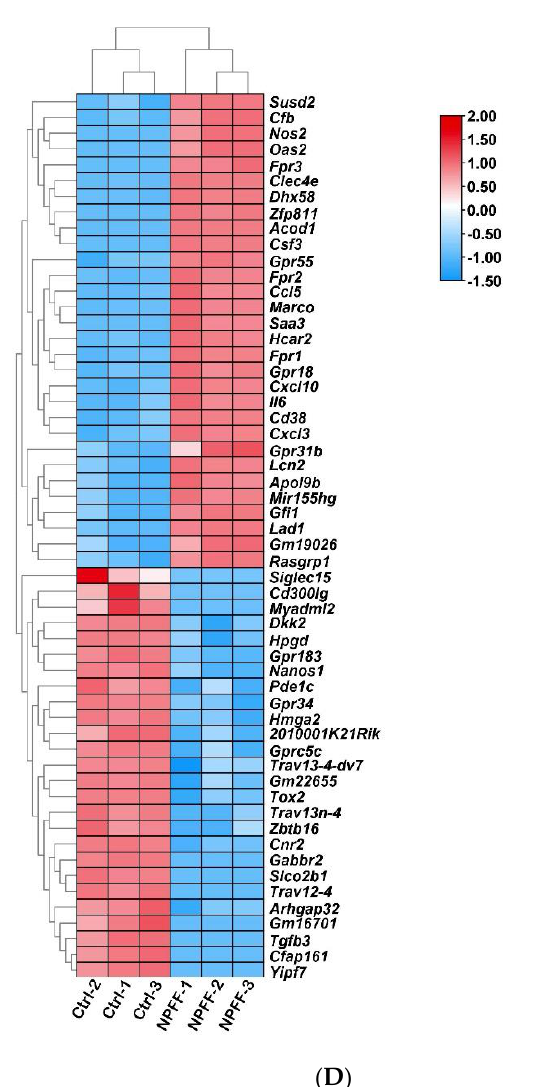
Figure 3. Basic information about RNA-seq results. ( A ) The proportion of differentiated expressed genes (DEGs) ( p -value < 0.05 and |log2(fc)| > 1). ( B ) Volcano plot of RNA-seq results (green dots: down-regulated genes; red dots: up-regulated genes). ( C ) Differentially expressed genes statistics ( p -value < 0.05 and |log2(fc)| > 1). ( D ) Heat map of the 48 DEGs with the largest absolute value of FoldChange (24 up-regulated DEGs and 24 down-regulated DEGs) and 8 hub genes. The red indicated the up-regulated genes and blue represented down-regulated genes.